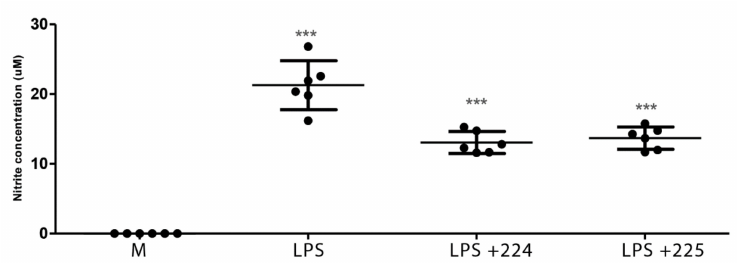
Figure 1. E ff ect of two samples of propolis (50 µ g / mL) from the UK on nitric oxide (NO) production by macrophages stimulated by lipopolysaccharide (LPS); n = 6 *** = p value < 0.001. Comparisons of LPS against medium and LPS + propolis samples 224 and 225 against LPS. Medium alone = M.